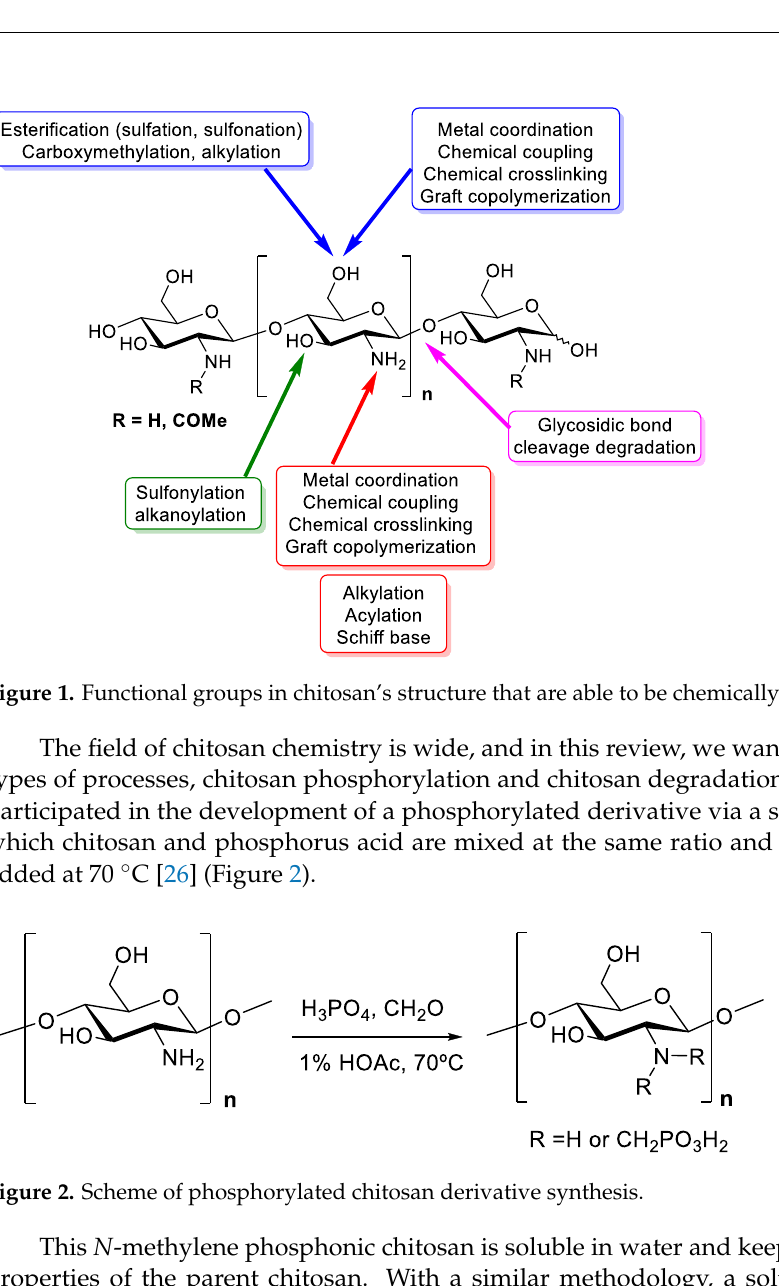
Figure 2. Scheme of phosphorylated chitosan derivative synthesis.